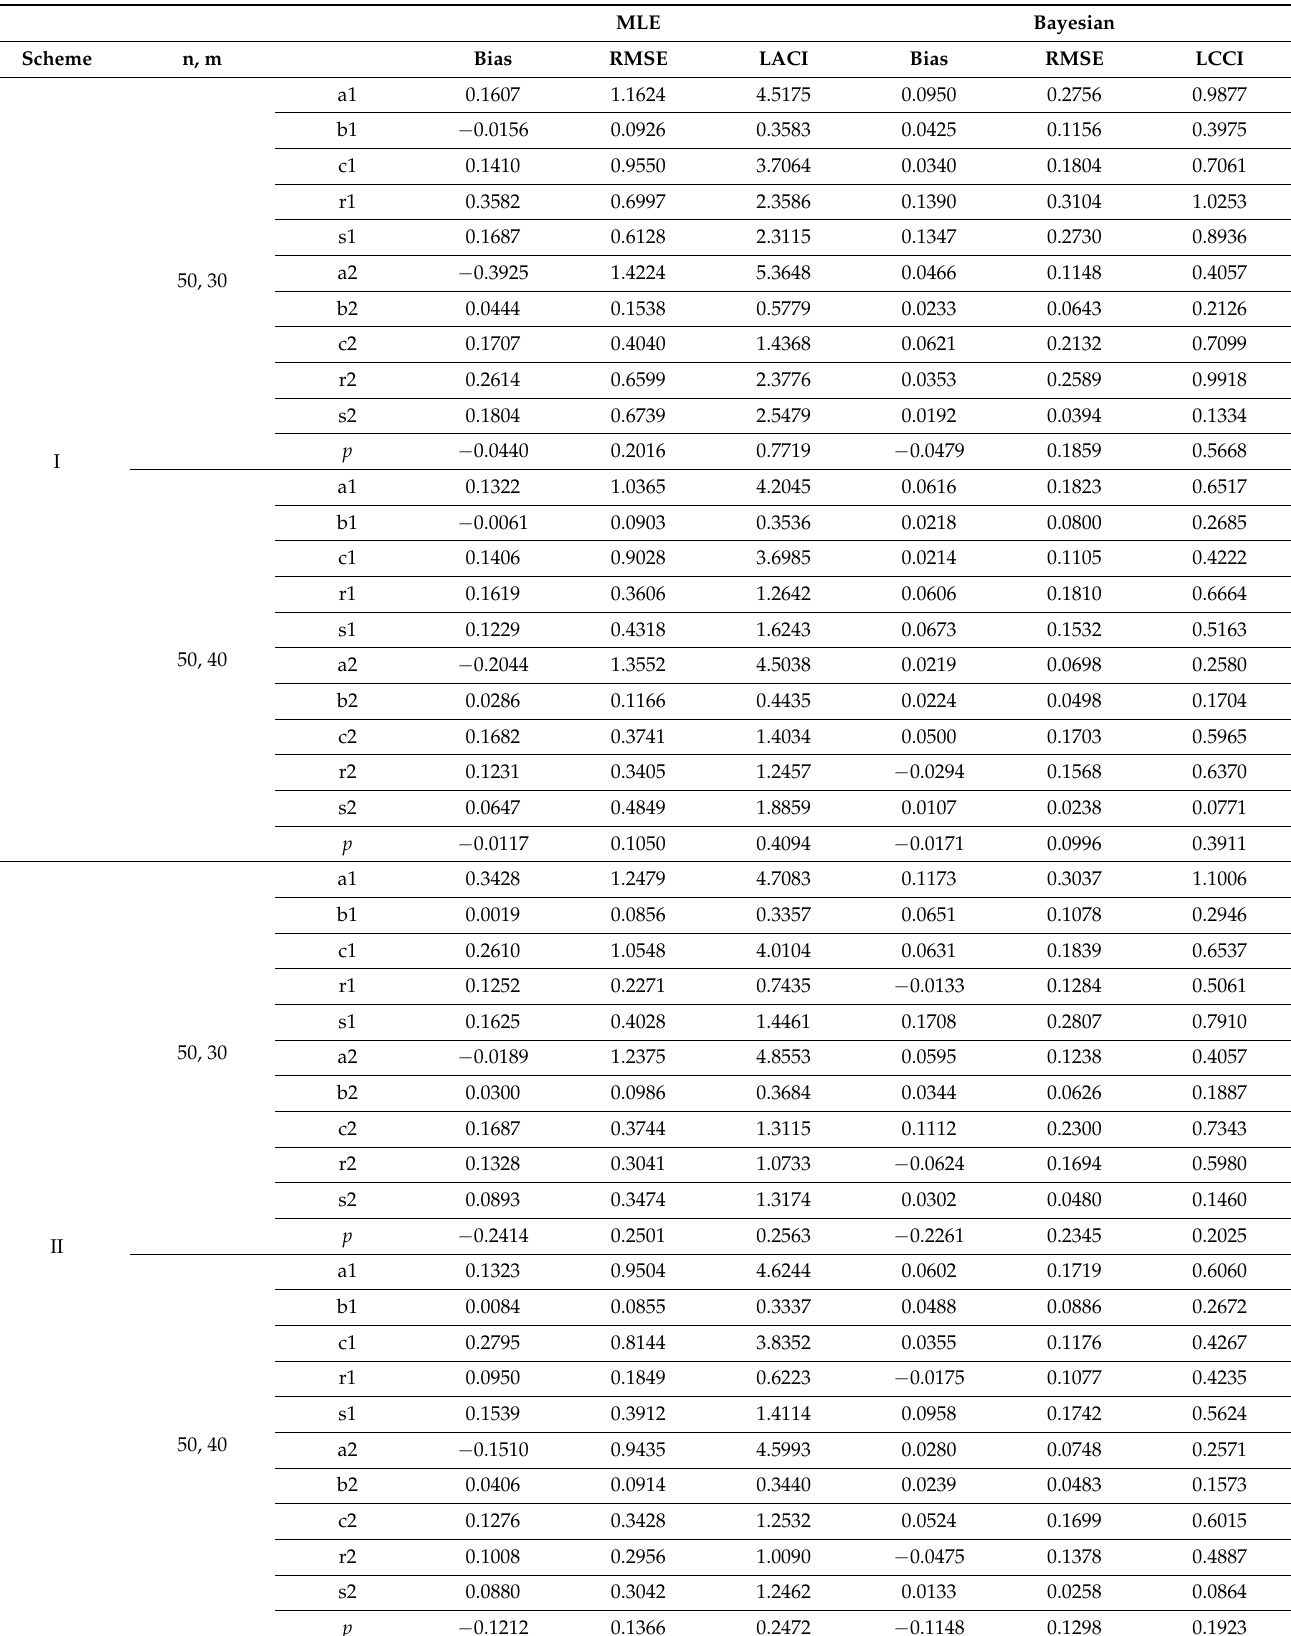
Table 7. Bias, RMSE and length of CI for the MLE and Bayesian estimates of the parameters are presented for different schemes: Case 2 and n =